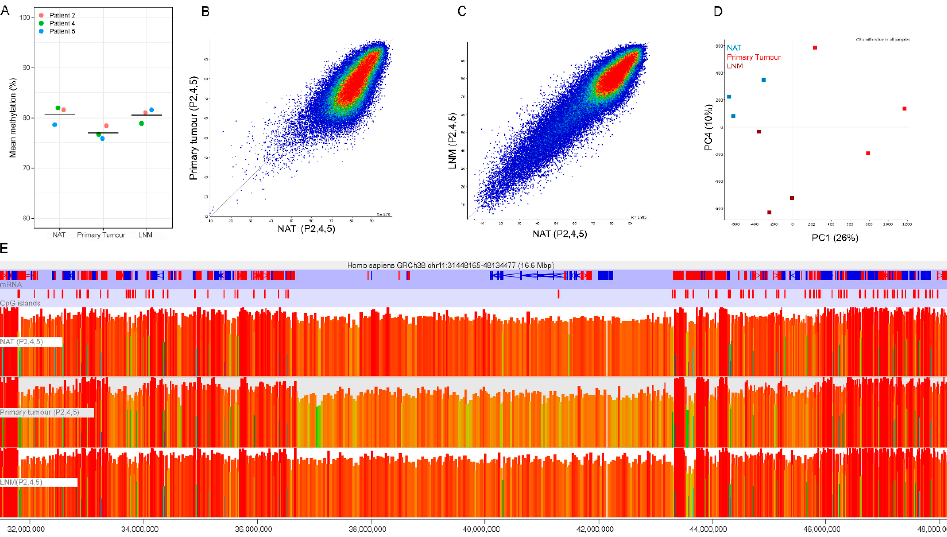
Figure 1. Methylation patterns of non-CGI regions in normal colon tissue (NAT), primary tumour and lymph node metastasis (LNM) samples of three CRC patients. ( A ) Mean methylation of non-CGI regions for each individual patient. The black line indicates the mean of the three patients (one-way ANOVA, p = 0.1360). ( B ) Scatterplot comparing methylation levels between NAT and primary tumour samples and ( C ) between NAT and LMN samples. Each dot indicates the average methylation of a 200 CpG window (excluding CGIs). ( D ) Principal component analysis showing clustering of normal, primary tumour and LNM samples on PC1 and PC4. ( E ) Screenshot of the genome showing large regions with lower methylation levels in primary tumour samples compared to NAT and LMN samples. Each bar represents a 200 CpG window. The height and colour of the bar indicate the methylation values. NAT: normal adjacent tissue; LNM: lymph node metastasis.